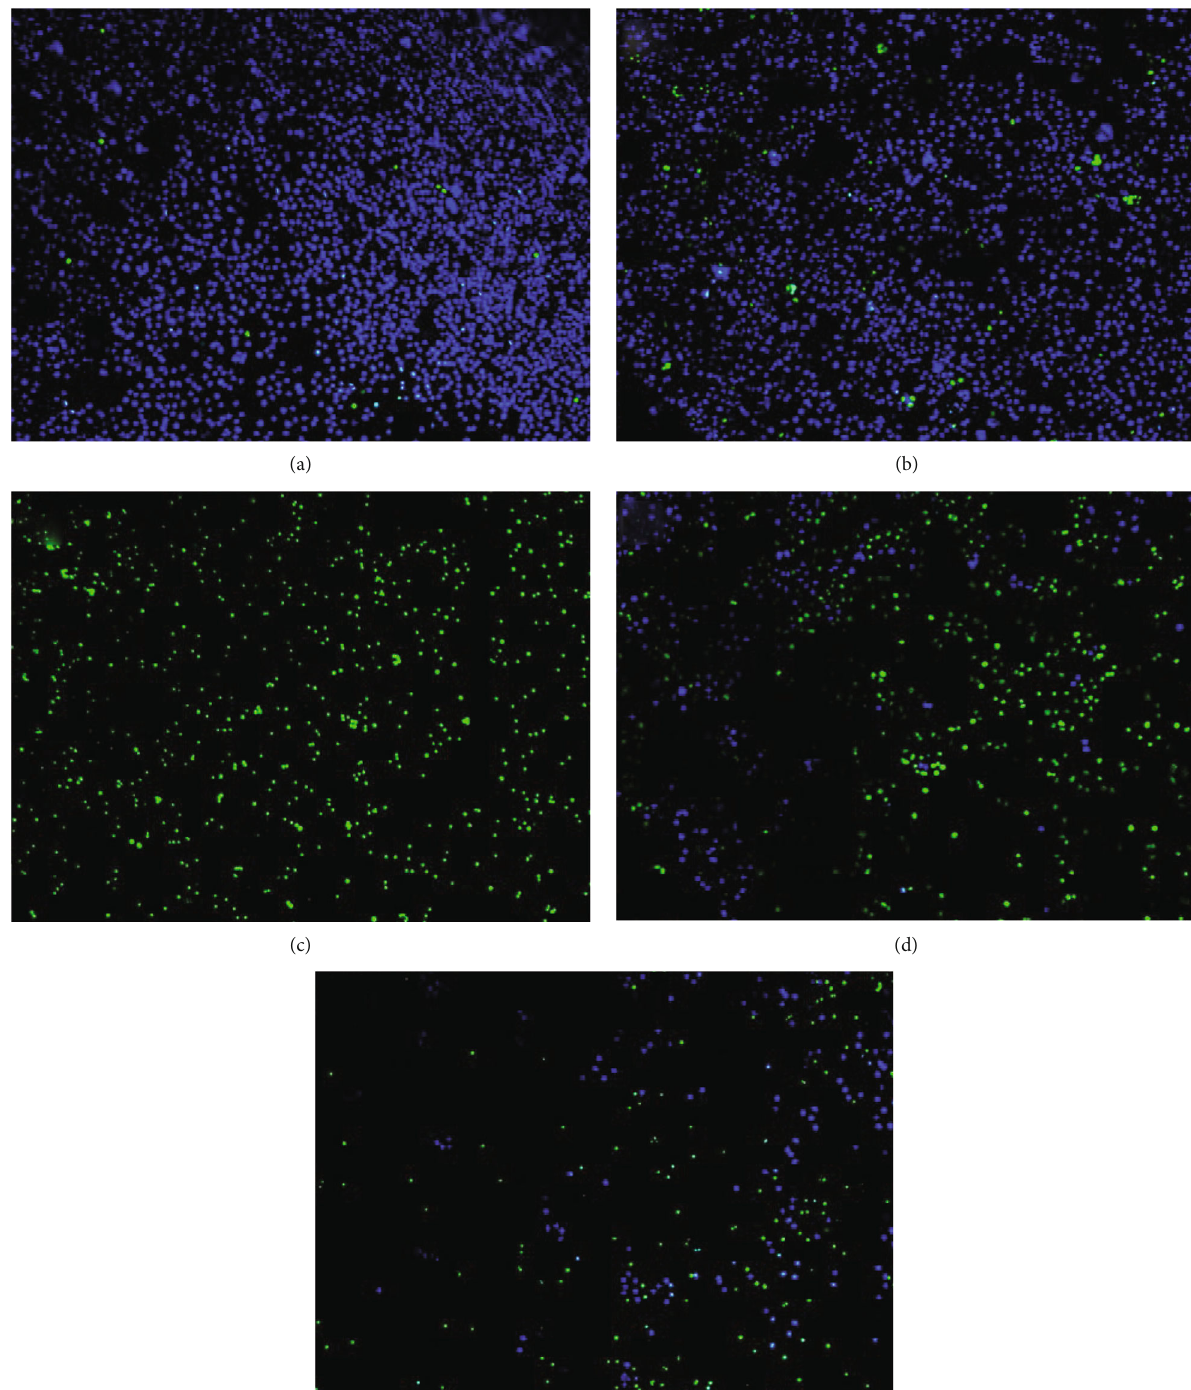
Figure 10: LIVE/DEAD assay: (a) MP